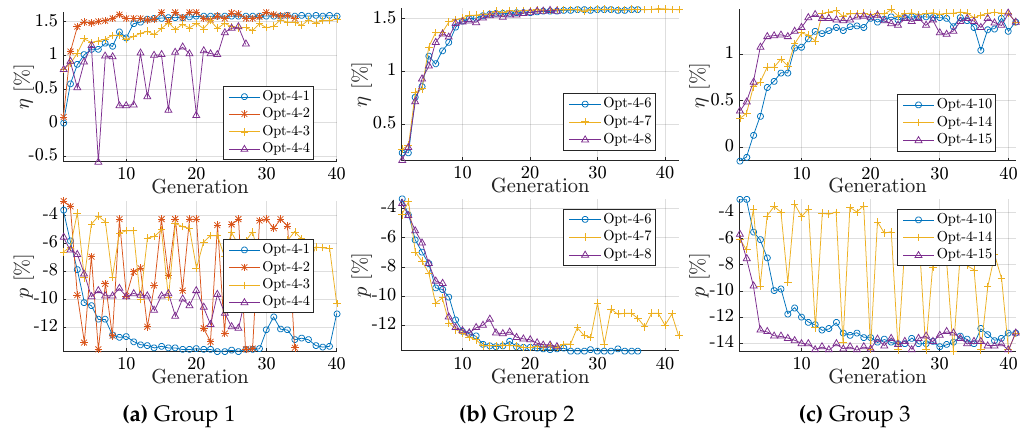
Figure A5. Development of objectives, given as median of relative improvements per generation.